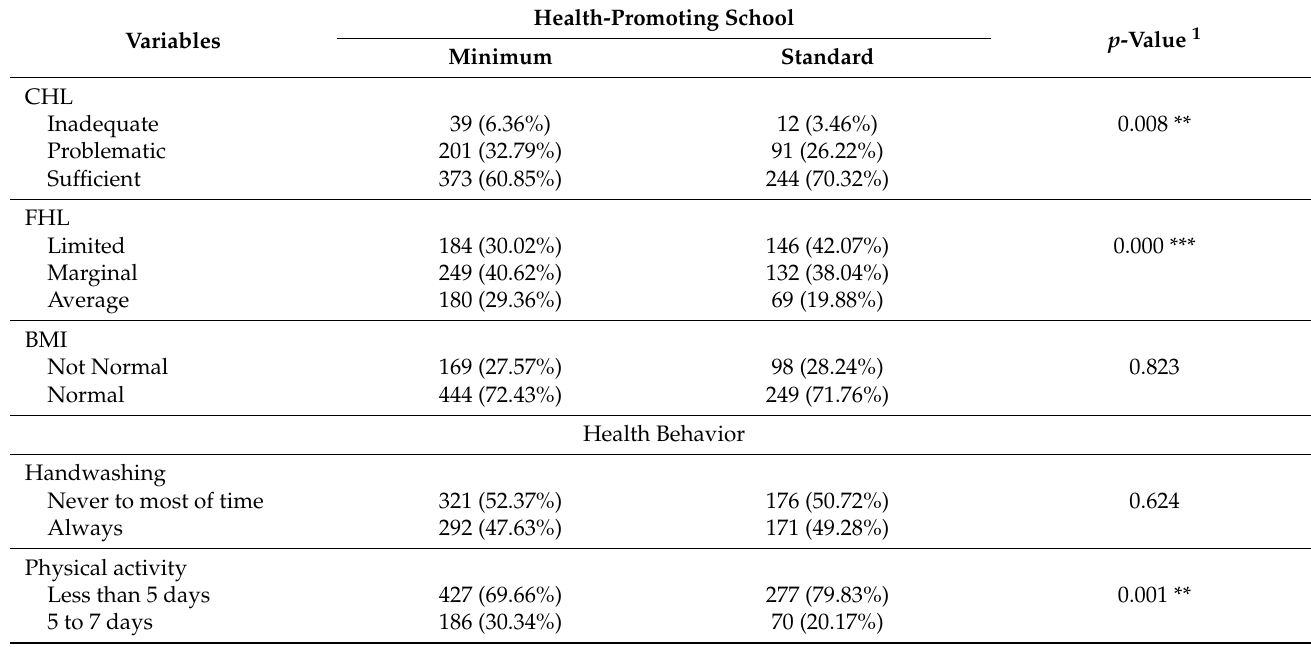
Table 2. Associations between health-promoting school with CHL, FHL dan health